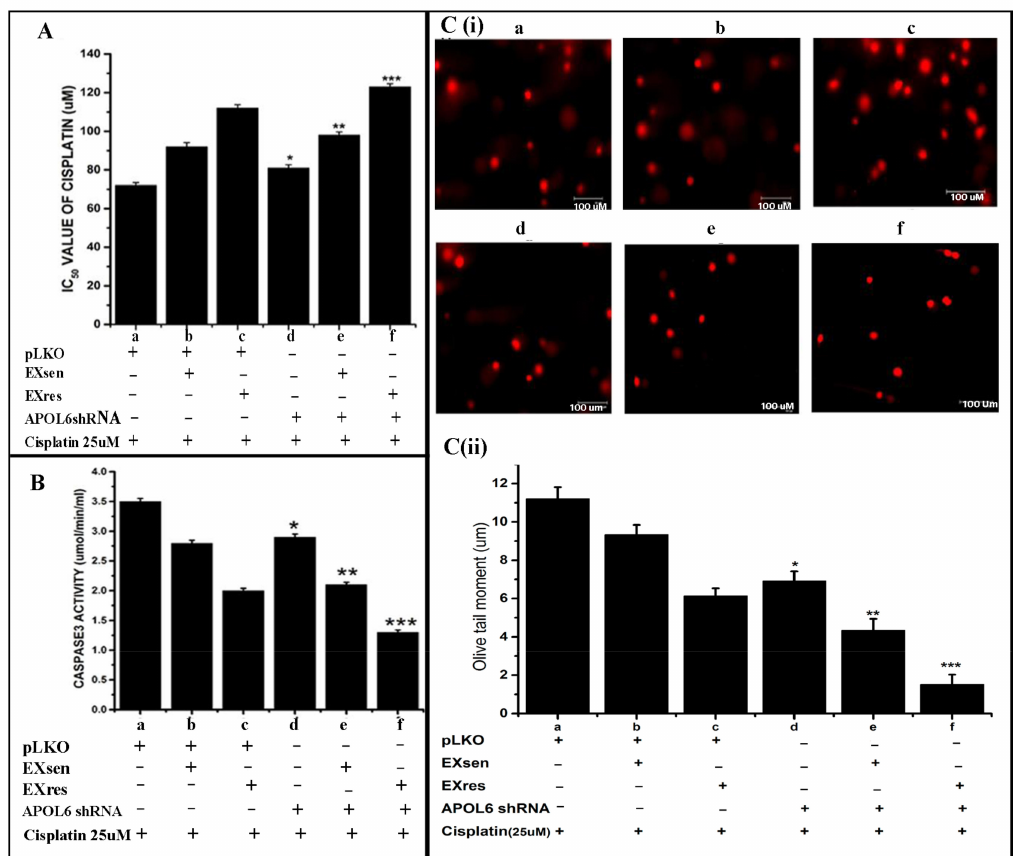
Figure 9. Effect of APOL6 knockdown on EXres-dependent alteration in cisplatin resistance. APOL6 knocked down cells were exposed to EXsen or EXres and cisplatin (25 µ M) followed by XTT assay, comet, and caspase3 activity assay. ( A ) XTT assay. ( B ) Caspase3 activity assay ( C ) ( i ) Representative microphotographs of comets and ( C ) ( ii ) Olive tail moment analysed by comet assay using open comet software. In ( A – C ), a represents pLKO vector control + cisplatin, b represents pLKO vector control + EXsen + cisplatin, c represents pLKOvector control + EXres + cisplatin, d represents APOL6 shRNA + cisplatin, e represents APOL6 shRNA + EXsen + cisplatin, and f represents APOL6 shRNA + EXres + cisplatin. The mean values of two different experiments ± SEM each performed in triplicate are reported in the graph, p < 0.05. * indicates statistical significance when compared to a. ** indicates statistical significance when compared to b. *** indicates statistical significance when compared to